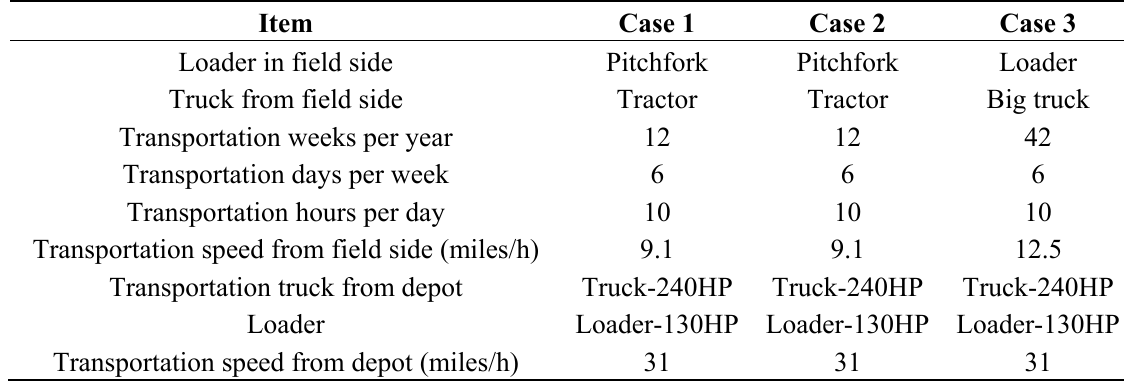
Table A2. Equipment and other elements used during transportation.